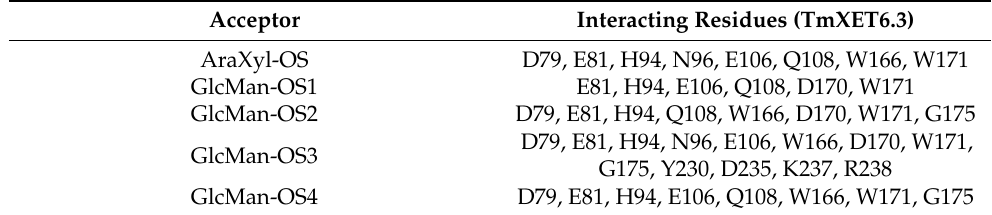
Table 8. The TmXET6.3 residues that interact with AraXyl-OS and GlcMan-OS acceptors over 50% of MD simulation times at distances of up to 4.0 Å.